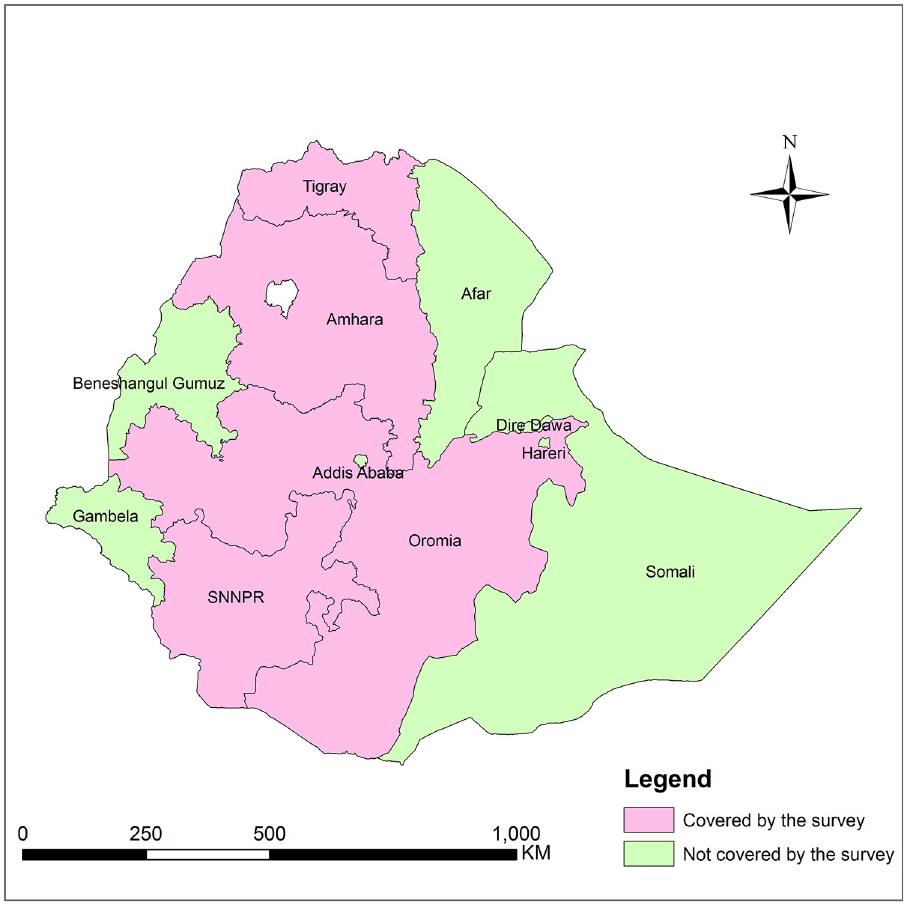
Fig 1. Map of Ethiopia showing regions covered by the survey. SNNPR: Southern Nations, Nationalities, and Peoples Region. Note: Currently there are two additional regions, namely Sidama and South West Ethiopia regions, which were created after the survey was conducted. The map is constructed based on shapefile obtained from open AFRICA (https://africaopendata.org/dataset/ethiopia-shapefiles; accessed on 01 February 2022).